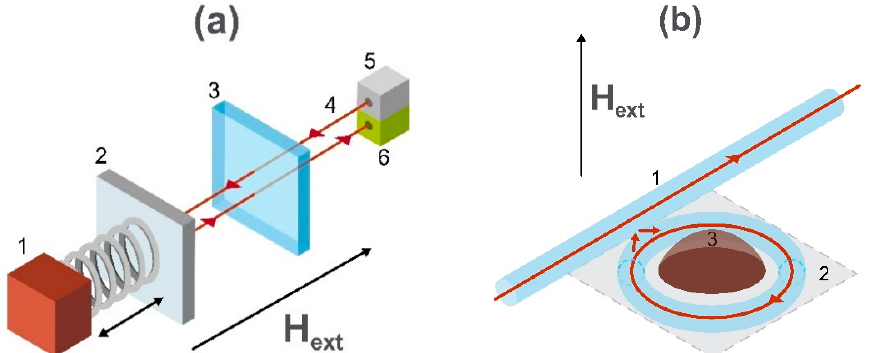
Figure 9. Schematic image of the working principle of the cavity optomechanical system. Panel ( a ) shows a mechanical resonator consisting of a magnetostrictive material (1) and moving mirror (2) bonded to the Fabry–Pérot optical resonator consisting of a fixed mirror (3), optical path length (4), light emitter (5), and detecting system (6). Panel ( b ) schematically represents the sensing element of the magnetometer including an optical fiber (1), resonator system (2), and magnetostrictive material (3) which is sensitive to the applied external magnetic field H ext .